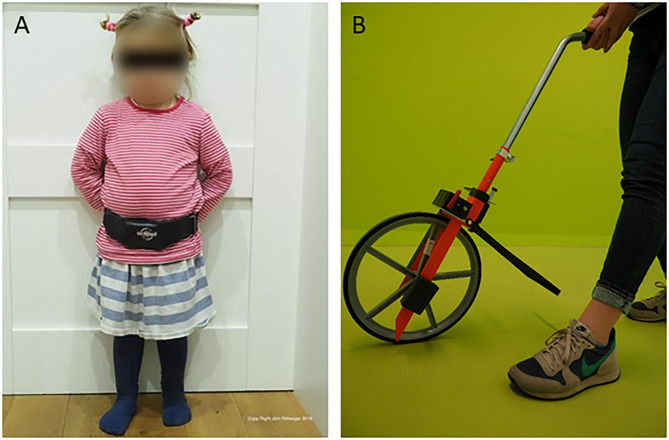
(A) 3-year old child wearing an actibelt®. (B) Mobile perambulator used in this study.